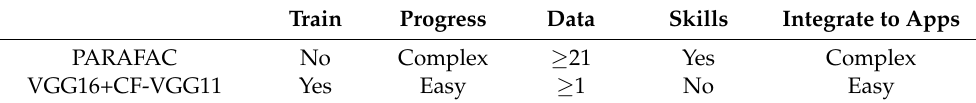
Table 5. Comparison between PARAFAC and VGG models